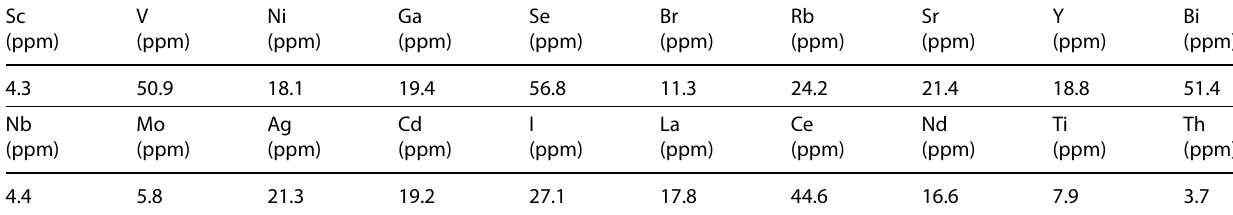
Table 2 X-ray fluorescence. Minor elements